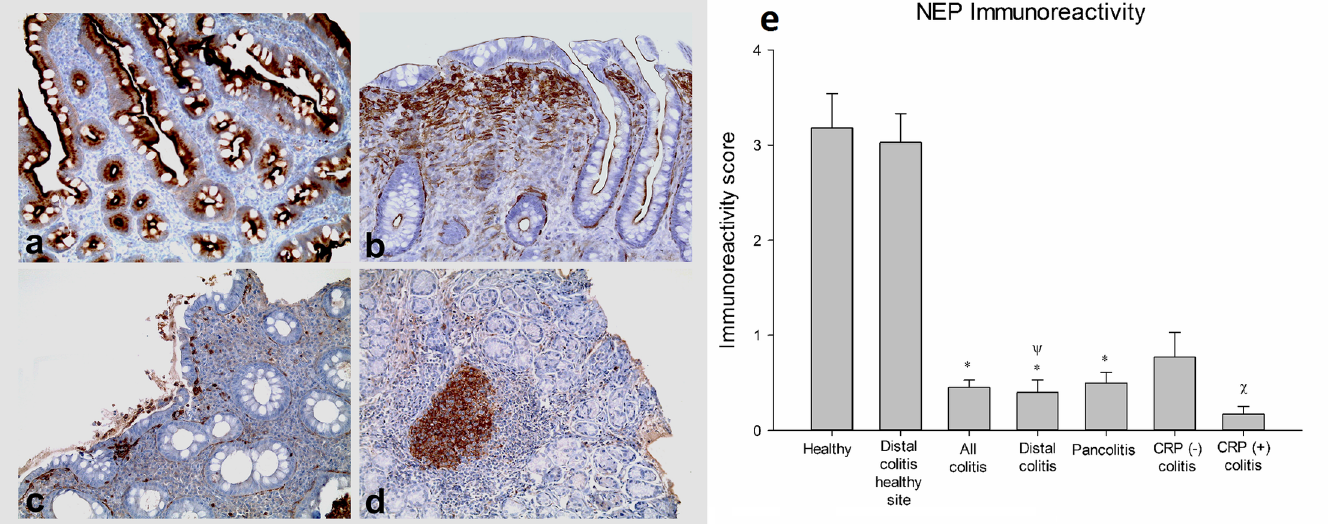
Fig 1. NEP expression in colonic mucosa. a: Normalmucosafrom a healthy subject. b: Uninvolved mucosa from a case of distal colitis. c: Mucosa from a case with distal colitis d: Inflamed mucosain an area of colitis from a case with pancolitis.There is considerable negativestainingin colitis. (Magnifications: a, b and c x100; d x50; CD10 stainingcounterstained with haematoxylin) e: Immunoreactivity score of neprilysin(mean ± SEM). * P < 0.05,comparedto healthy tissue. Ψ P < 0.05,comparedto distal colitis healthysite. P < 0.05comparedto CRP negativepatients with UC.